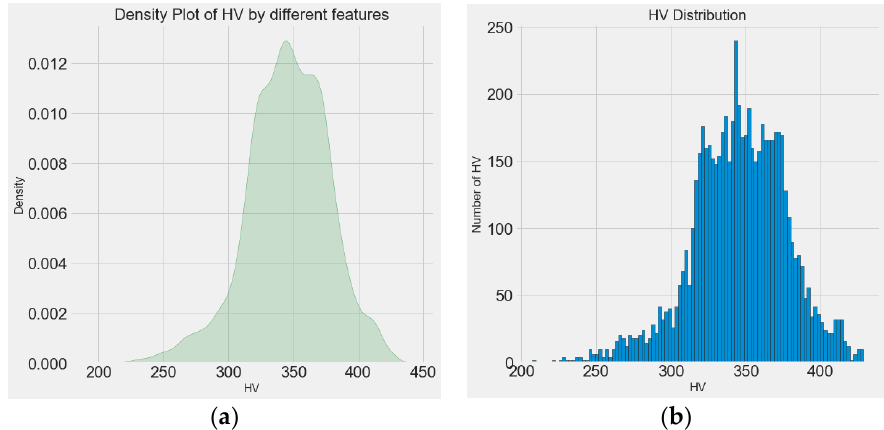
Figure 7. Distribution of microhardness data. ( a ) Microhardness density graph and ( b ) histogram of microhardness distribution.